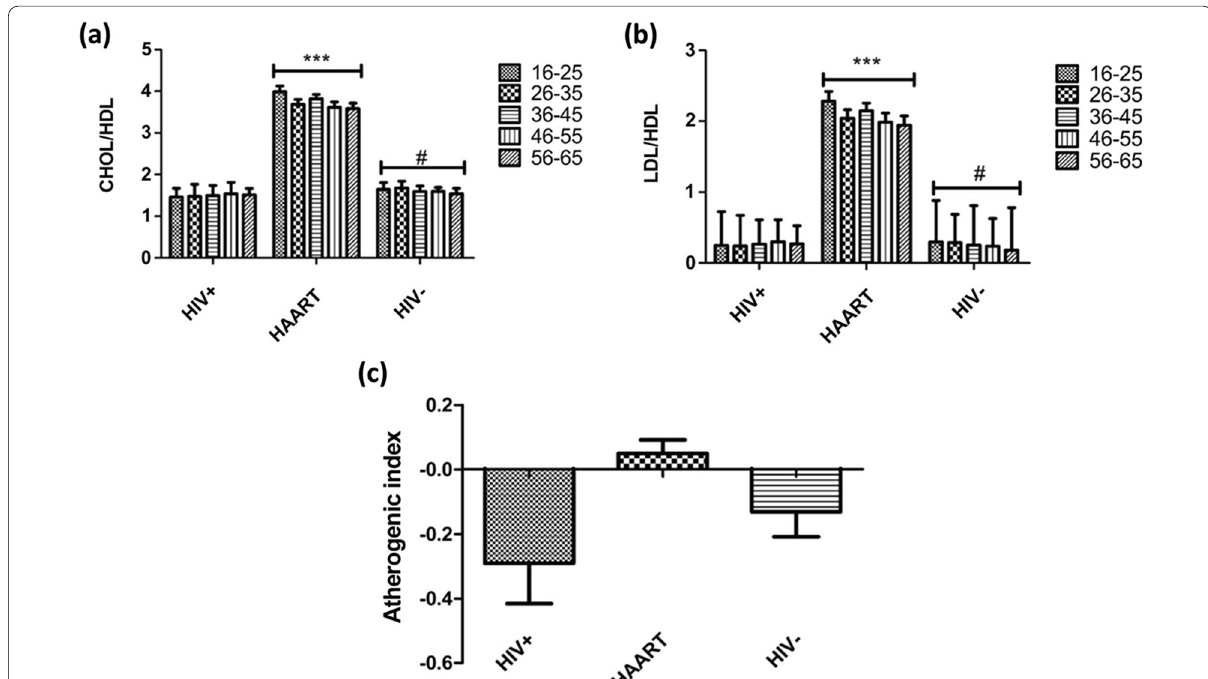
Fig. 2 a Cholesterol/HDL-c ratio of age-matched HIV-positive patients, HIV patients after a year on HAART, and HIV-negative subjects. *** p < 0.001 versus HIV-positive and HIV-negative; # p > 0.05 versus HIV-positive. Cholesterol/HDL-c ratio in HIV-positive patients was not significantly different from values for normal subjects but the ratio was skewed in HIV-positive patients on HAART; b LDL/HDL-c ratio of age-matched HIV-positive patients, HIV patients after a year of HAART, and HIV-negative subjects. *** p < 0.001 versus HIV-positive and HIV-negative; # p > 0.05 versus HIV-positive. LDL/HDL-c ratios were similar in HIV-positive patients and normal subjects but skewed in HIV-positive patients on HAART; c Atherogenic index of plasma (AIP) of HIV-positive patients, HIV patients after a year of HAART, and HIV-negative subjects. Each value is significantly different from the others ( p < 0.05). Values indicated a lower cardiovascular risk for HIV-positive and HIV-negative